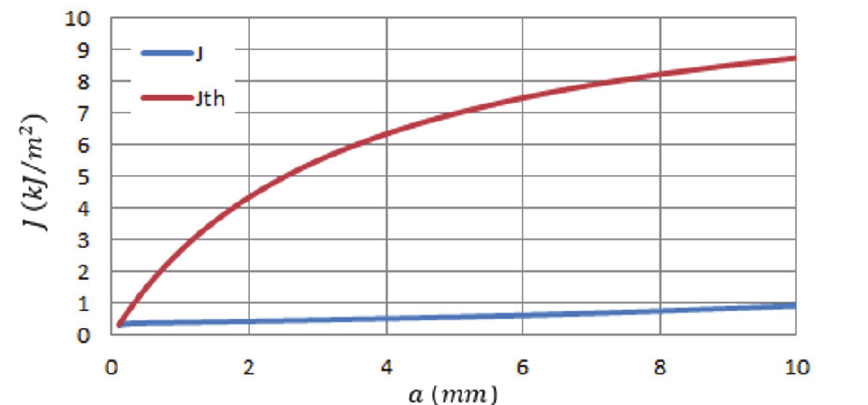
Figure 8: Curves J I (a)  a and J EACth (a)  a generated by the analysis of the DC(T) loaded by P  3.1kN under EP conditions.